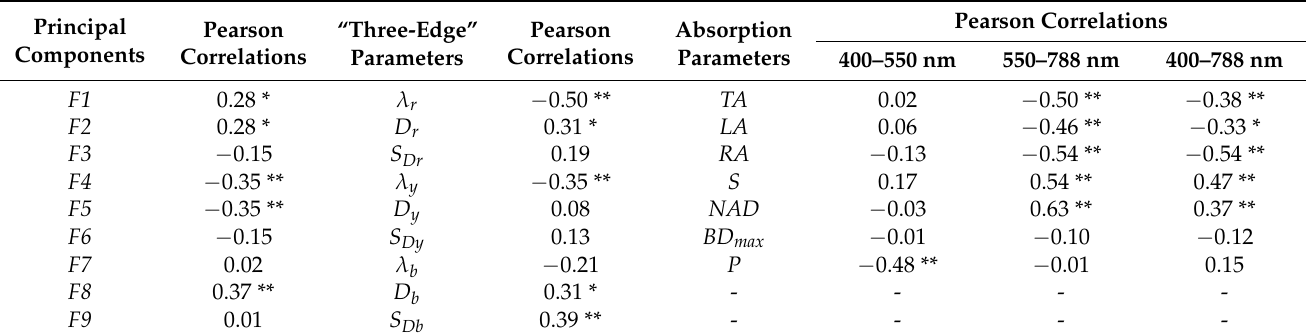
Table 5. Correlation between principal components, “three-edge” parameters, spectral absorption parameters and Anth of tree peony leaves.